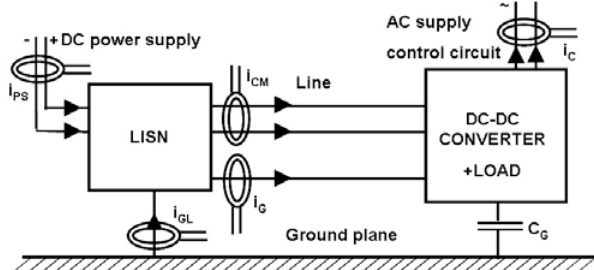
Figure 17: Common mode current